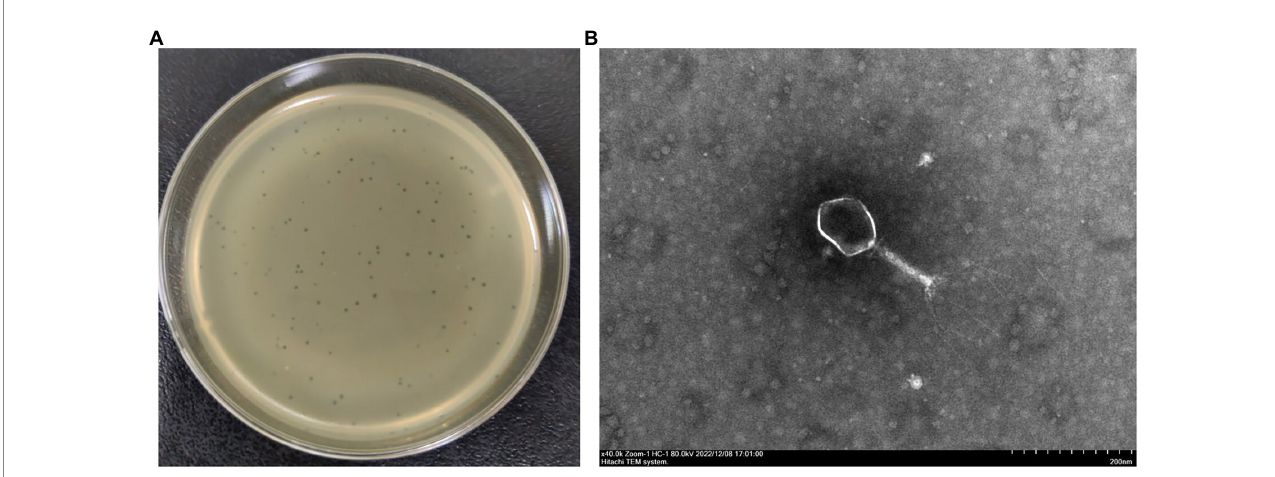
FIGURE 1 Morphological characteristics of phage CE1. Clear plaques produced by phage CE1 on an agar plate (A) ; TEM image of phage CE1 consisting of an icosahedral head (80 ~ 100 nm in dimeter) and a retractable tail (120 nm in length) (B)